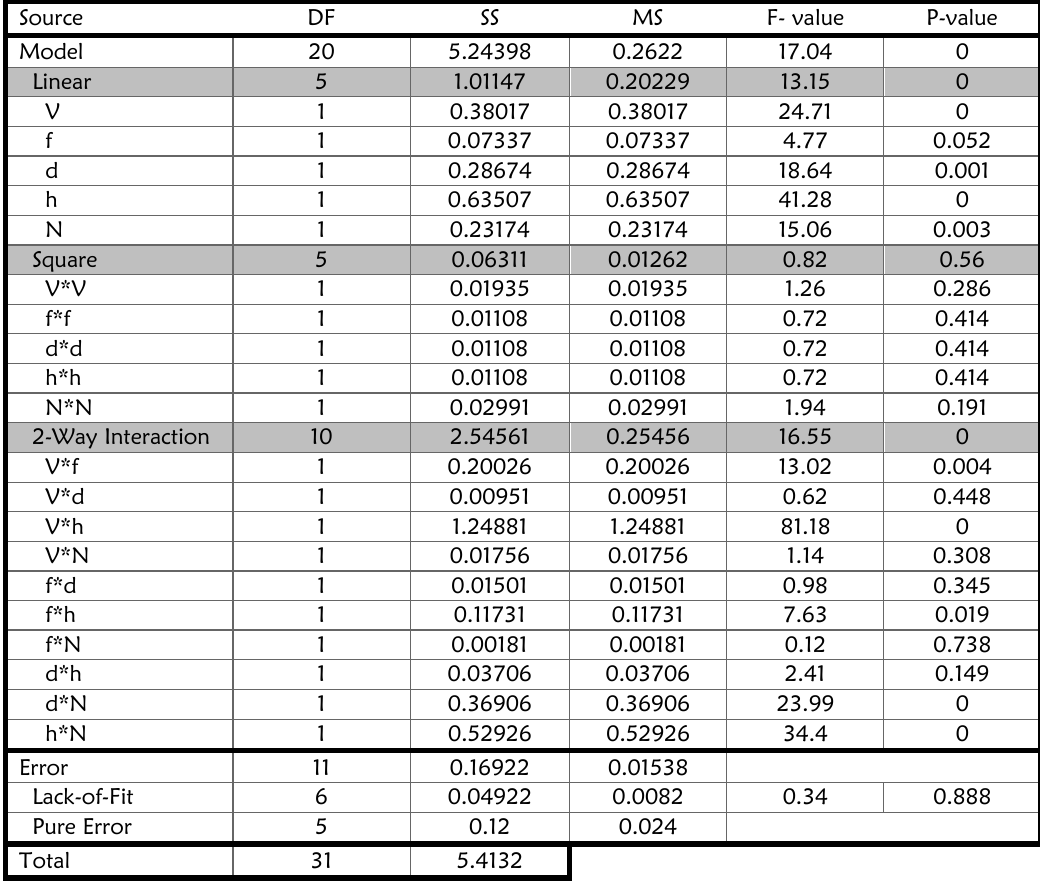
Table 4: ANOVA analysis in WECT process